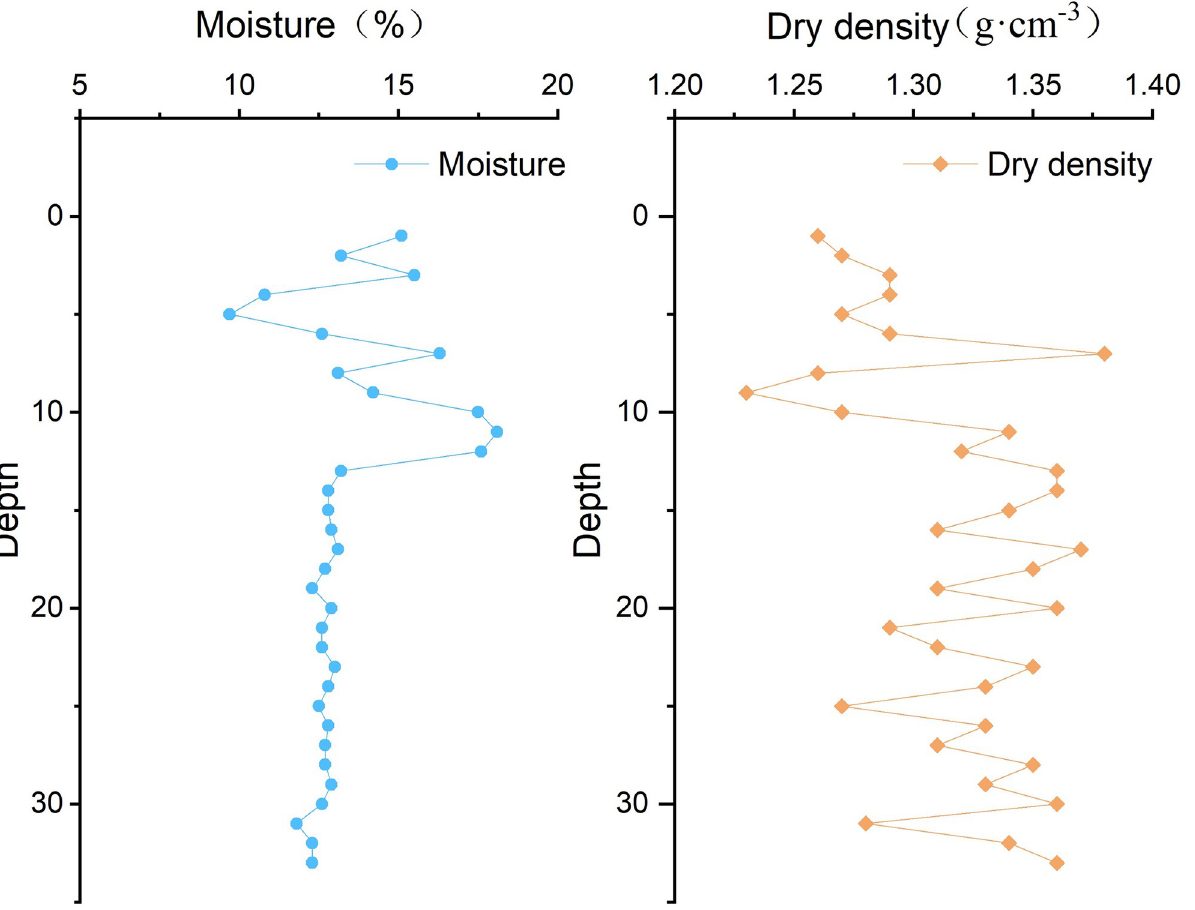
Fig 11. Comparison of moisture and dry density of compacted loess in different